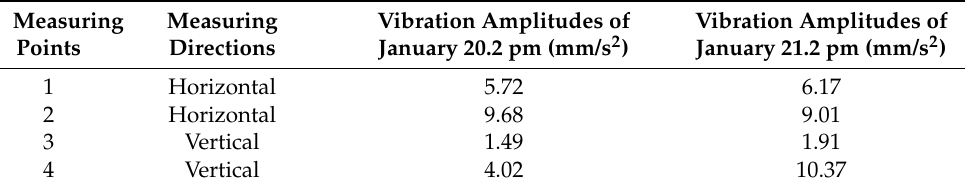
Table 2. Measured amplitudes of the four measuring